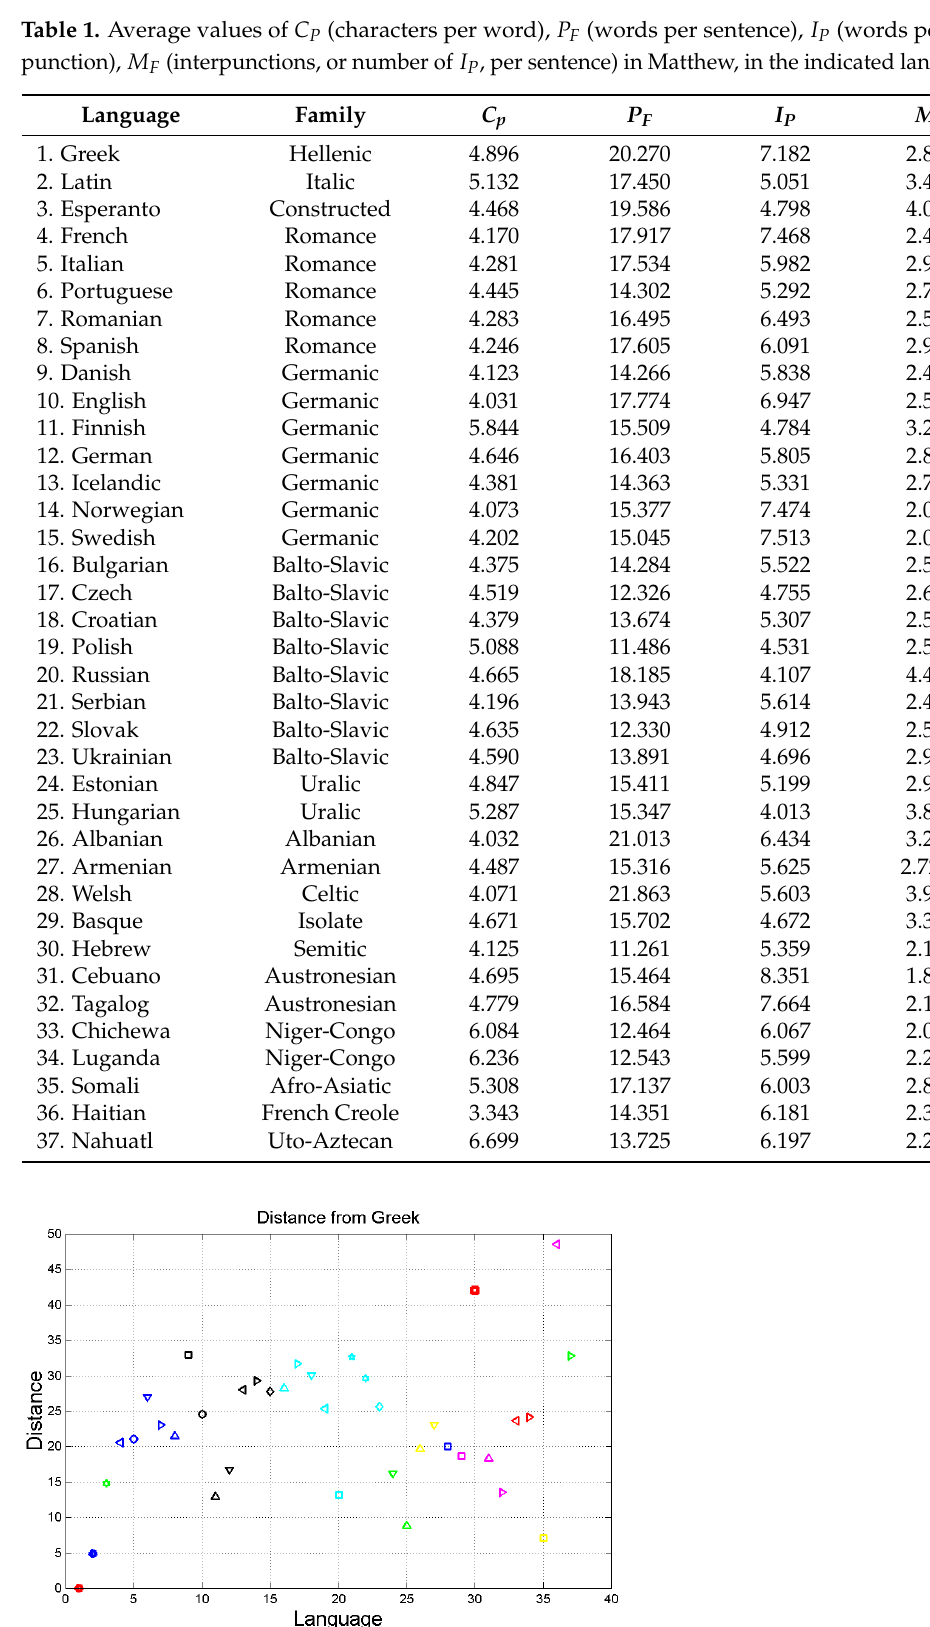
Figure 3. Distance 𝑑 from Matthew according to the language indicated in abscissa. The order of languages is the same as in Table 1. Greek (language no.1) is at 𝑑 (cid:3404) 0 ; Latin (2) at 𝑑 (cid:3404) 5 ; English at d = 25,